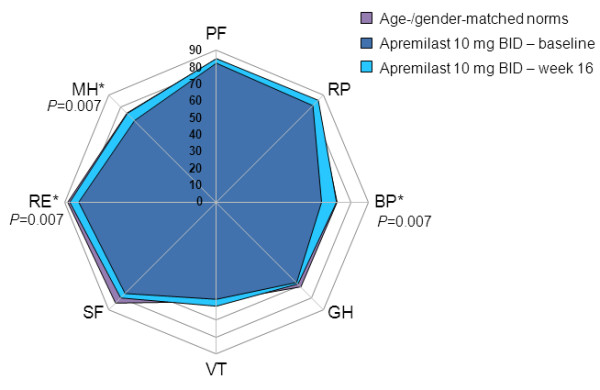
SF-36 domain scores at baseline and week 16 with apremilast 10 mg BID. Spydergram of SF-36 domain scores in patients receiving apremilast 10 mg BID versus US age-/gender-matched norms (lavender) and baseline (dark blue). Gridlines represent changes of 10 points each (10 points = 2× MCID). An increase in score indicates improvement. Treatment-associated improvements (light blue) are statistically significant and ≥MCID in three of eight domains. MCID, minimal clinically important difference; SF-36, 36-item Short-Form Health Survey. *≥MCID.